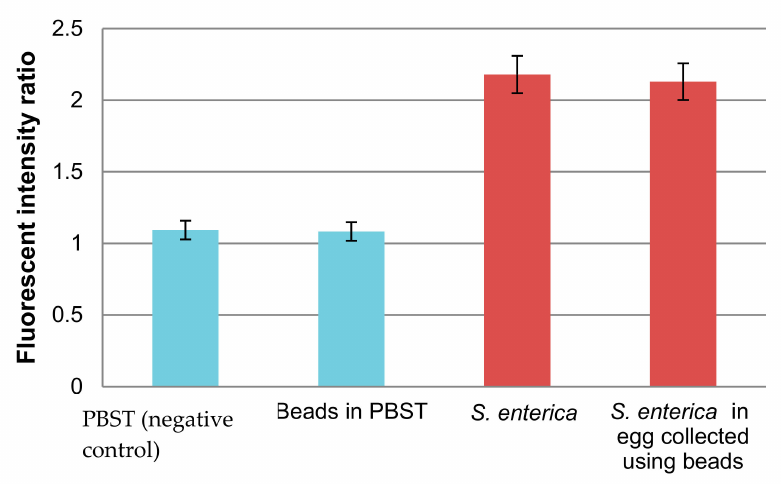
Figure 4. E ff ect of immunomagnetic beads on the PCR of invA in a tube. Concentration of S. enterica = 5 × 10 5 cells / mL, N =